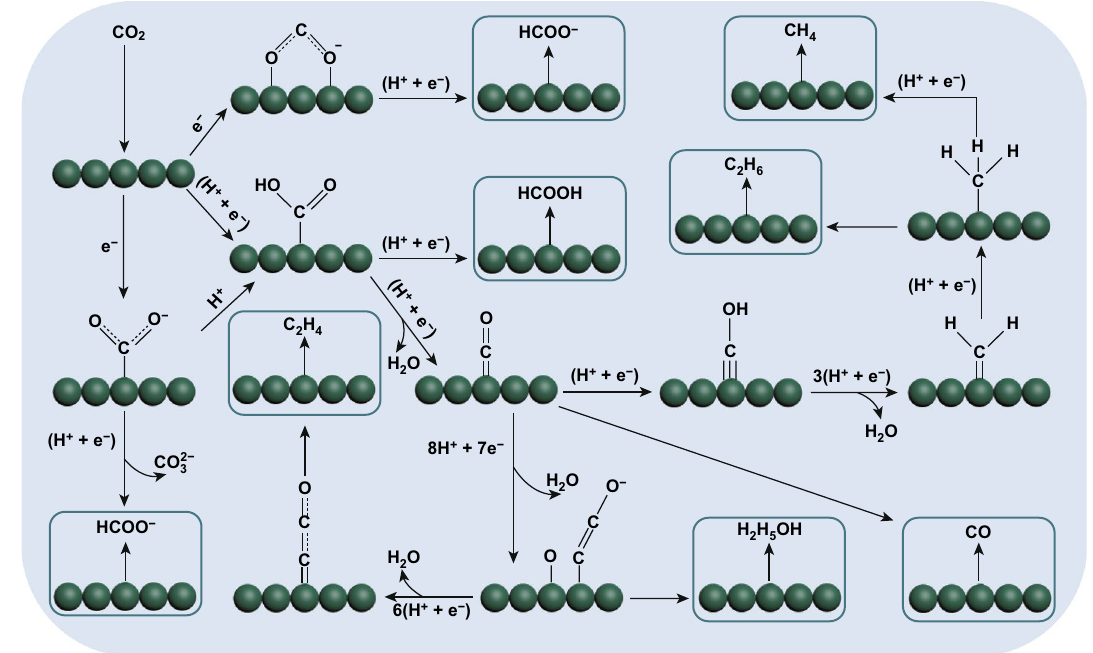
Fig. 1 Potential ECR pathways to form the products of CO, HCOOH, CH 4 , C 2 H 4 , C 2 H 6 , and C 2 H 5 OH